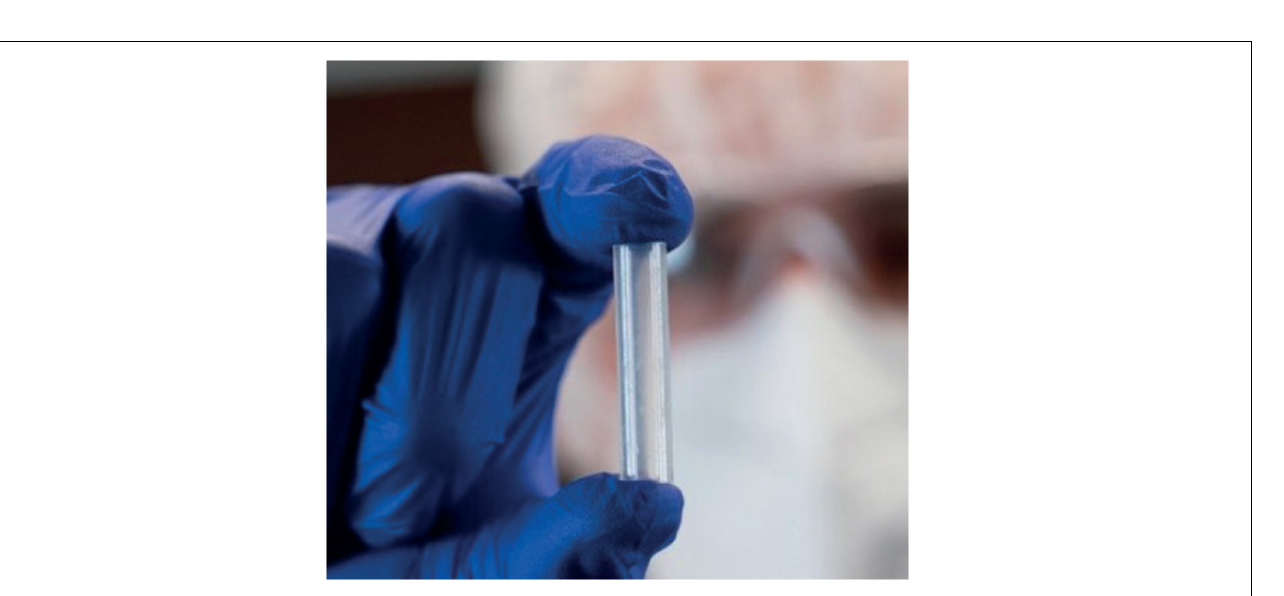
FIGURE 6 | Photograph of getxent odor adsorption